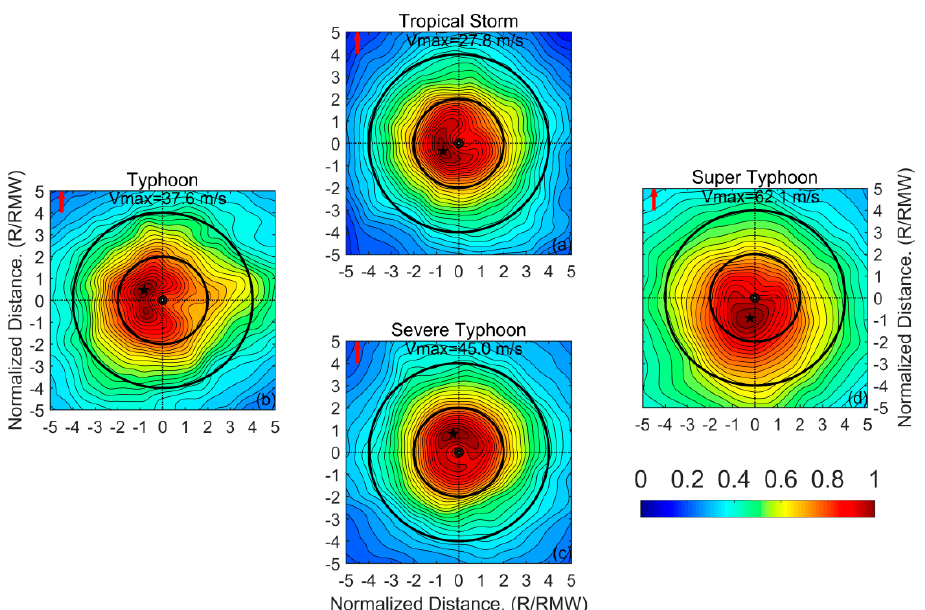
Figure 5. Composites of normalized two-dimensional SMAP wind speed fields are illustrated for ( a ) a tropical storm, ( b ) typhoon, ( c ) severe typhoon, and ( d ) super typhoon, as shown in Figure 3. Isoline intervals are 0.025 normalized units, and the maximum wind speed is equal to a value of 1. The red arrow and the black star indicate the direction of the wind shear and the location of the maximum wind speed in each group, respectively. The average maximum wind speed in each of the different groups is marked at the top of each panel. Black circles with radii 2 × RMW and 4 × RMW are also shown, for easy comparison among the different groups.